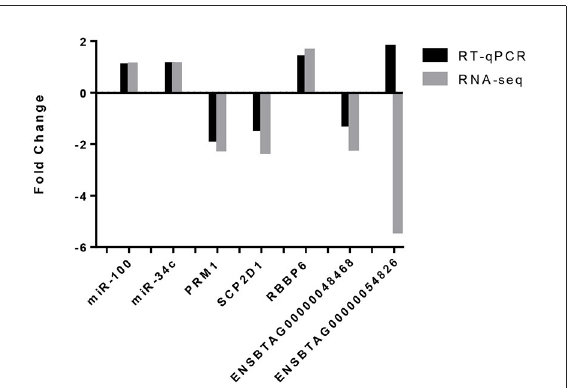
FIGURE3 Volcano plot depicting an overview of differential miRNA expression between bulls of varying fertility. The red dots indicate genes deemed significantly differentially expressed between bulls of high and low fertility. Genes with a positive log fold change were upregulated in the low fertility group. The gray horizontal line depicts the p -value threshold cut-off ( P < 0.05). TABLE 3 List of the 20 most highly expressed miRNAs.